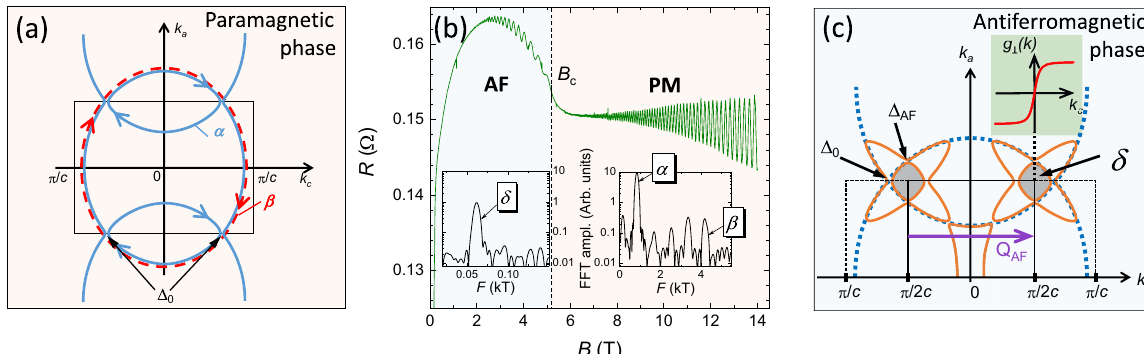
Fig. 1 2D Fermi surface of κ -BETS in the paramagnetic and antiferromagnetic phases. a Fermi surface of κ -BETS in the PM state 15,54 (blue lines). The blue arrows show the classical cyclotron orbits α and the red arrows the large MB orbit β , which involves tunneling through four MB gaps Δ 0 in a strong magnetic fi eld. b Interlayer magnetoresistance of the κ -BETS sample, recorded at T = 0.5 K with fi eld applied nearly perpendicularly to the layers ( θ = 2°). The vertical dashed line indicates the transition between the low- fi eld AF and high- fi eld PM states. The insets show the fast Fourier transforms (FFT) of the SdH oscillations for fi eld windows [2 – 5] T and [12 – 14] T in the AF and PM state, respectively. c The BZ boundaries in the AF state with the wave vector Q AF = ( π / c , 0) and in the PM state are shown by solid-black and dashed-black lines, respectively. The dotted-blue and solid-orange lines show, respectively, the original and reconstructed Fermi surfaces 16 . The shaded area in the corner of the magnetic BZ, separated from the rest of the Fermi surface by gaps Δ 0 and Δ AF , is the δ pocket responsible for the SdH oscillations in the AF state. The inset shows the function g ⊥ ( k